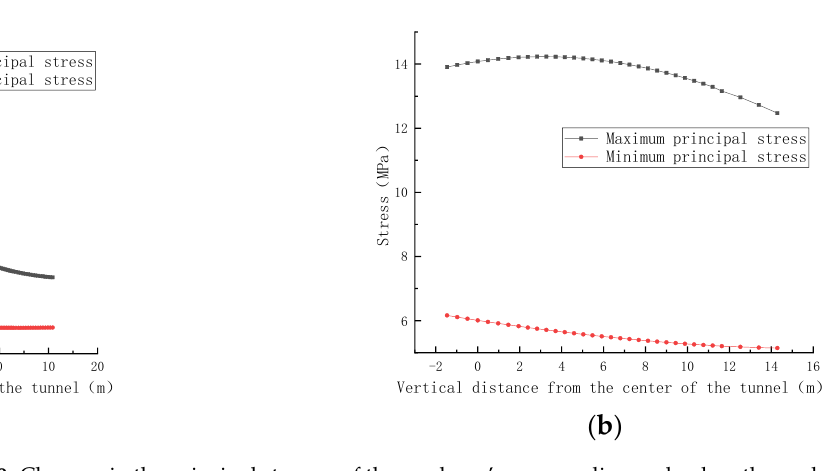
Figure 19. Changes in the principal stresses of the roadway’s surrounding rock when the coal column is 8 m. ( a ) Horizontal direction. ( b ) Variation direction.